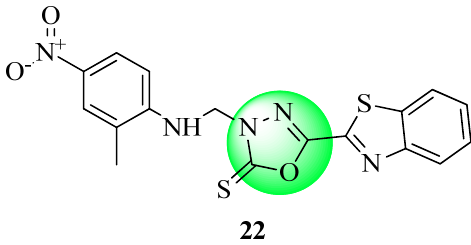
Figure 14. Benzothiazole clubbed oxadiazole-Mannich base.